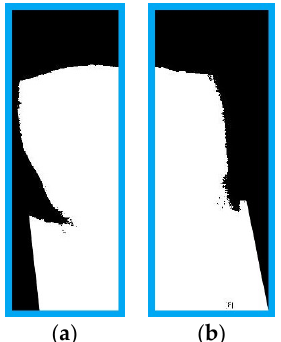
Figure 6. Photo of a single tooth sliced into photos of its ( a ) the right side and ( b ) the left side.